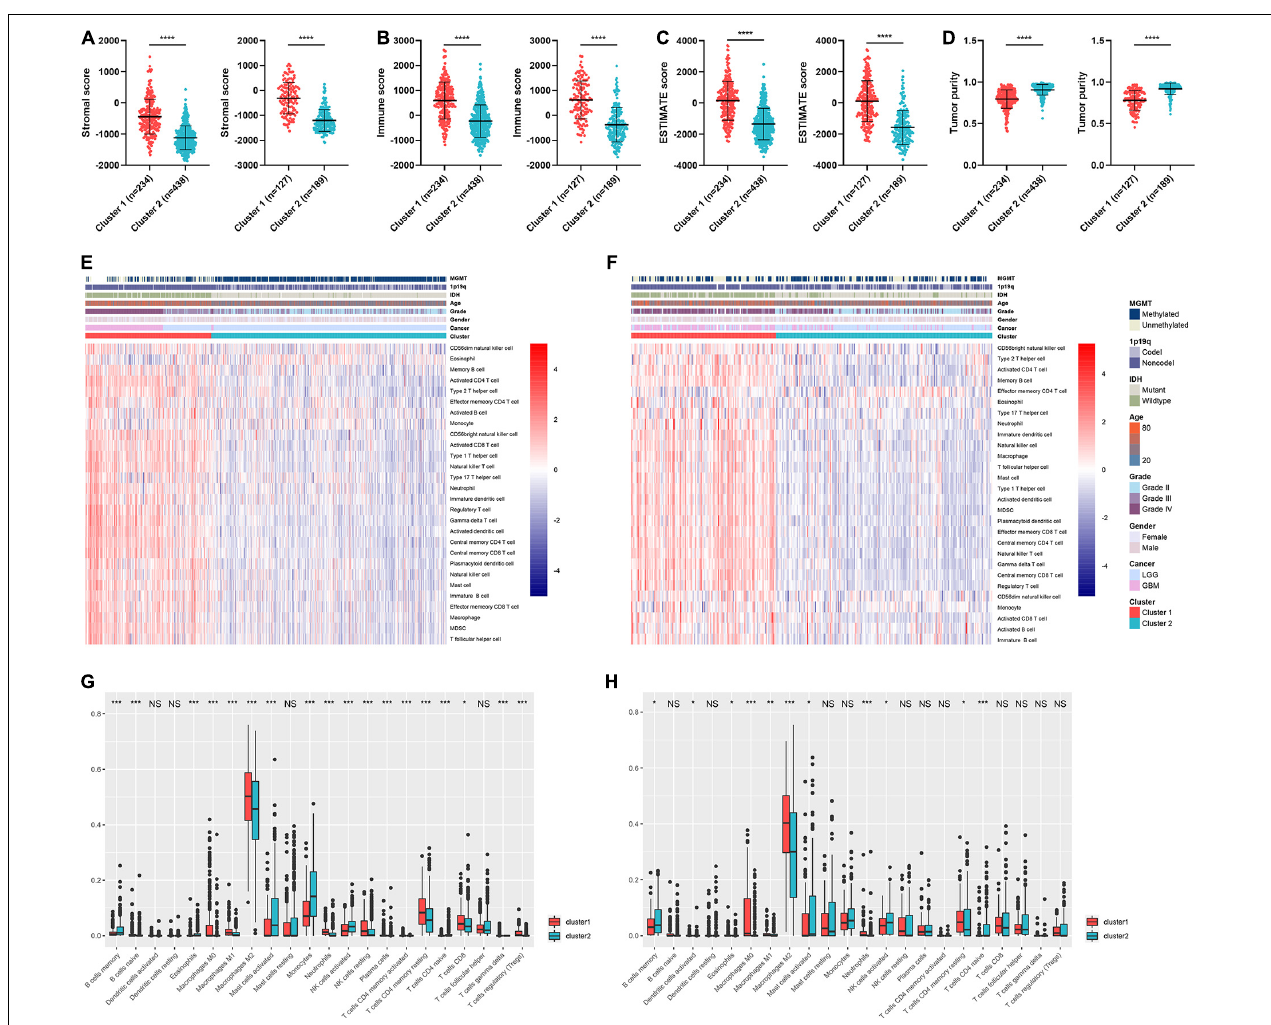
FIGURE 4 | Tumor purity and immune infiltration in two clusters. (A–D) The stromal score (A) , immune score (B) , ESTIMATE score (C) , and tumor purity (D) of two clusters in TCGA and CGGA datasets. (E,F) The infiltration of different immune cells revealed by ssGSEA algorithm in two clusters in TCGA (E) and CGGA (F) datasets. (G,H) CIBERSORT algorithm revealed the abundance of different immune cells in two clusters in TCGA (G) and CGGA (H) datasets. ∗ p < 0.05; ∗∗ p < 0.01; ∗∗∗ p < 0.001; ∗∗∗∗ p <